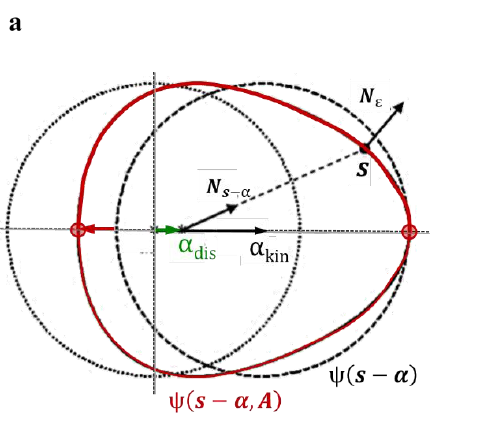
Figure 12. HAH 14 model’s description of orthogonal hardening in a two -step loading process. Re- printed with permission from Ref. [66]. 2013, Barlat, F. et al.